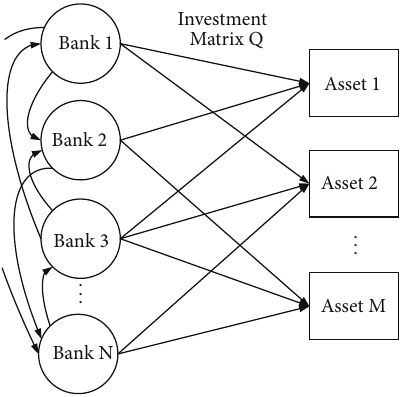
Figure 1: The structure of interbank market with overlapping